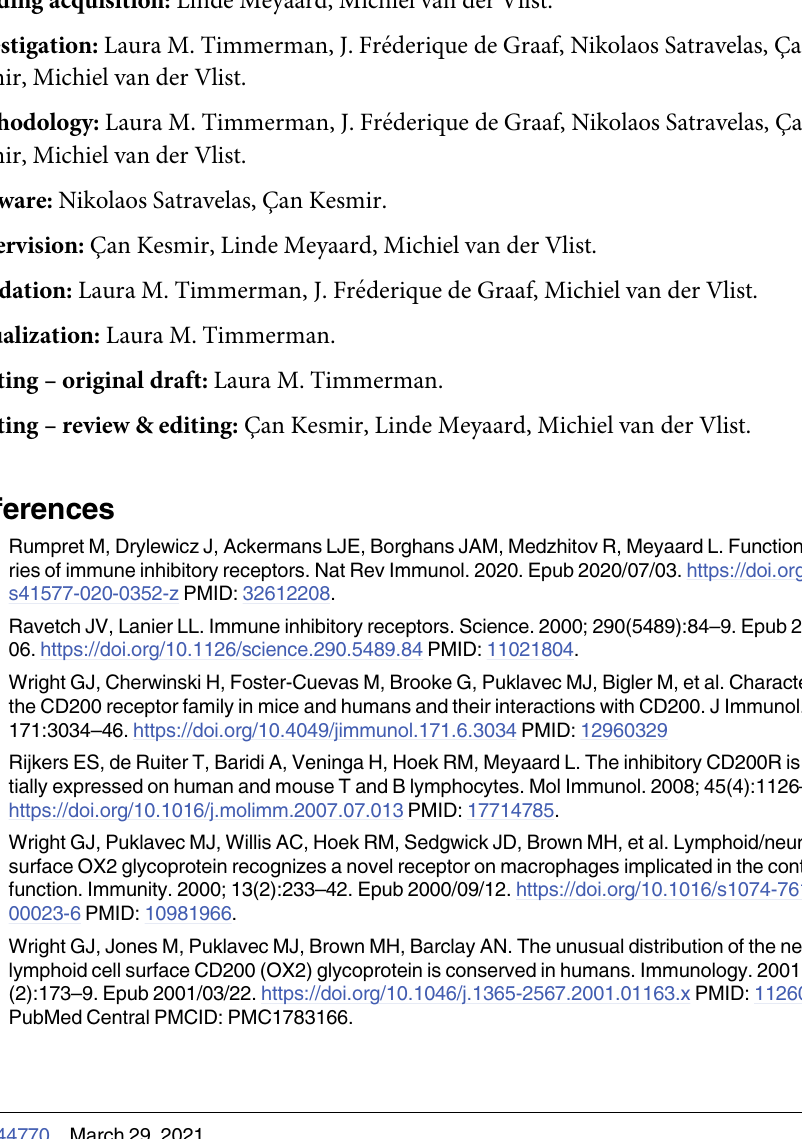
S1 Data. Raw data and calculations of the data shown in Fig 3B and Fig